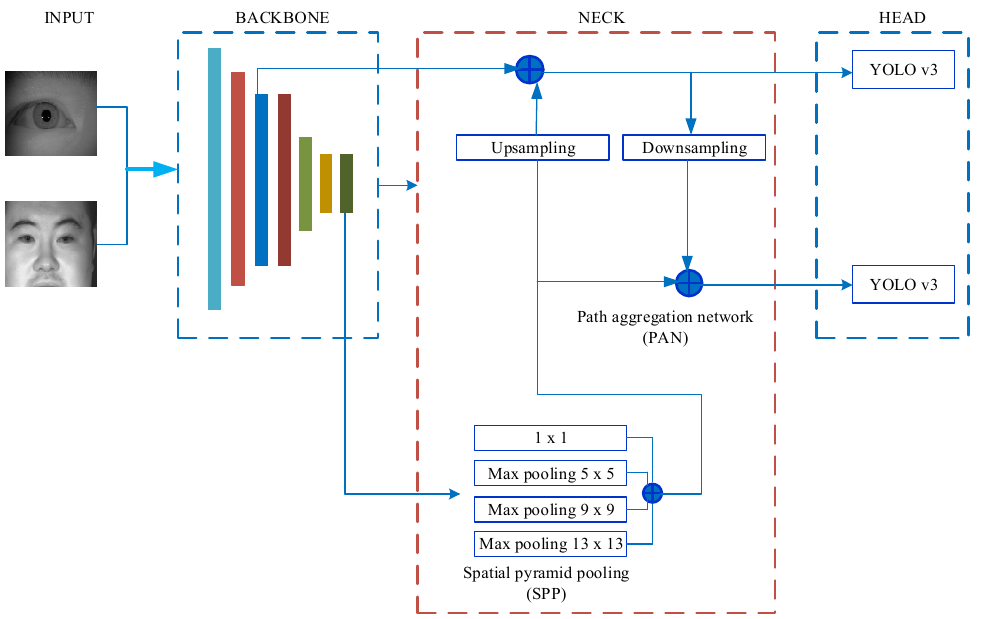
Figure 4. The overall network structure of modified YOLO v4